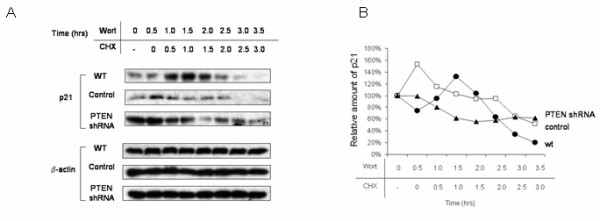
Stabilization of p21 in PTEN-knockdown cells is abrogated by PI3K inhibition with wortmannin. a. Wild type ACHN cells as well as those stably transfected with PTEN-shRNA or empty vector were incubated with wortmannin (50 nM) for the times indicated in the presence of cycloheximide (CHX; 20 μg/ml) for the times indicated, and cell lysates were immunoblotted with antibodies to p21 and β-actin. b. A graphical representation of the data using densitometry of p21 and actin bands is reported as ratio of p21/β-actin and is normalized to the "0 CHX control" for each lane. A representative experiment is shown of three done.